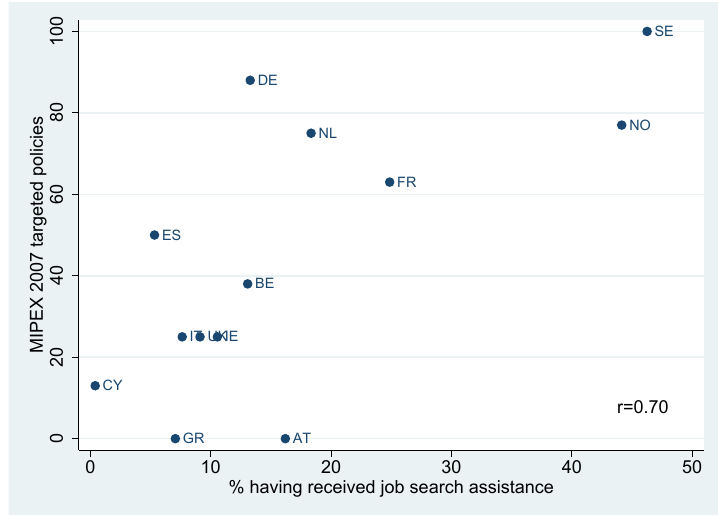
Figure 6: Proportion of third-country immigrants who received labor market counseling and countries’ MIPEX of labor market mobility, access to targeted